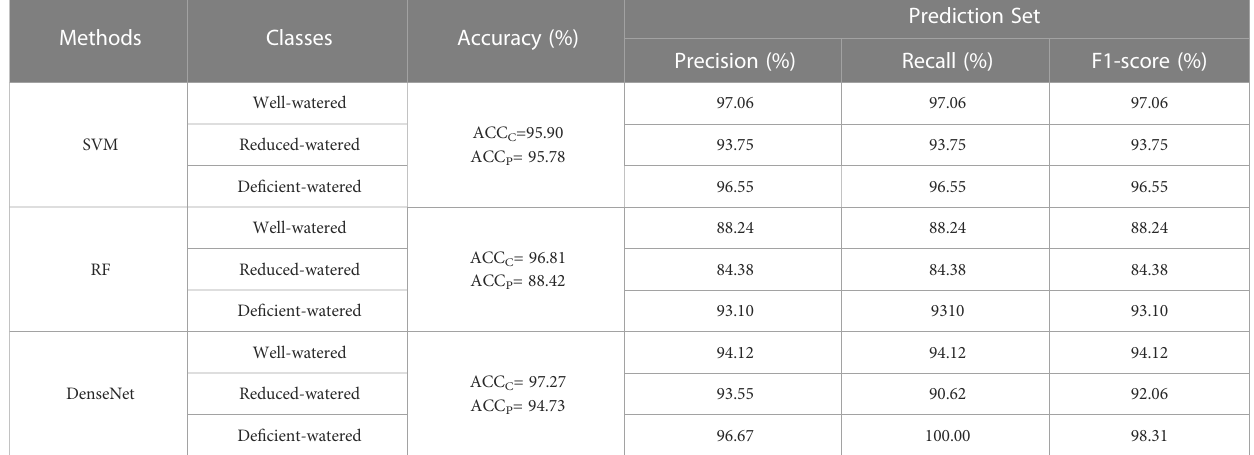
TABLE 4 Classi fi cation results of tomato plant DS based on subsample fusion.